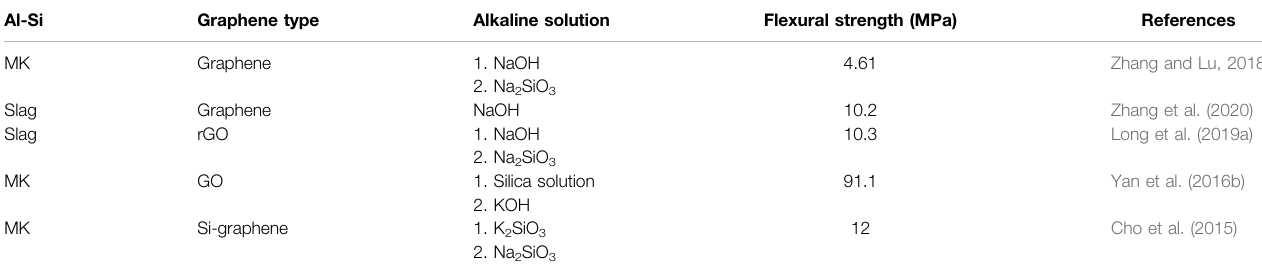
TABLE 5 | Summary of fl exural strength for Graphene Reinforced Geopolymer Nanocomposites.